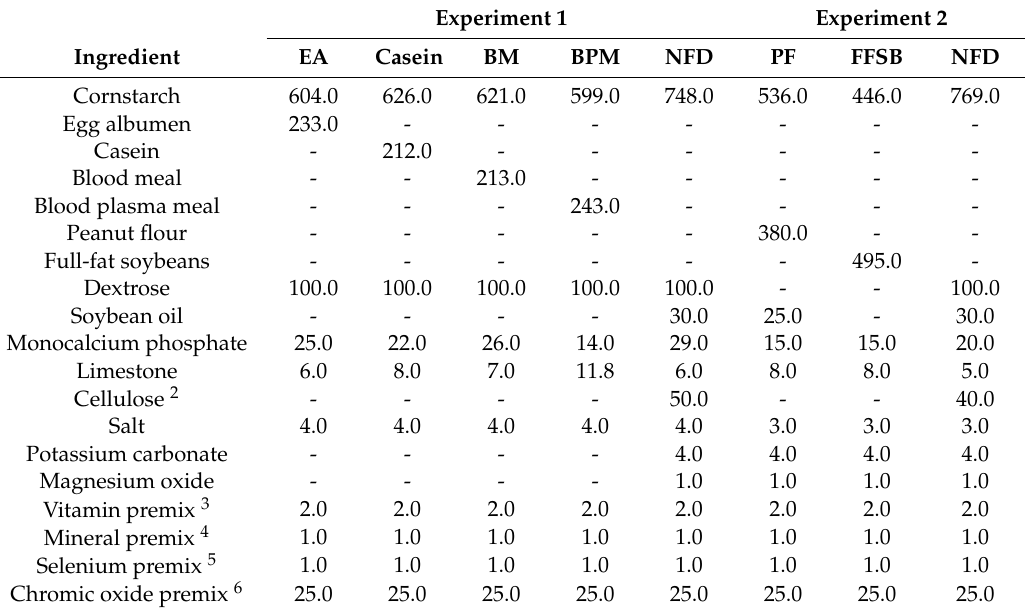
Table 1. Ingredient composition of experimental diets, g / kg as-fed basis 1